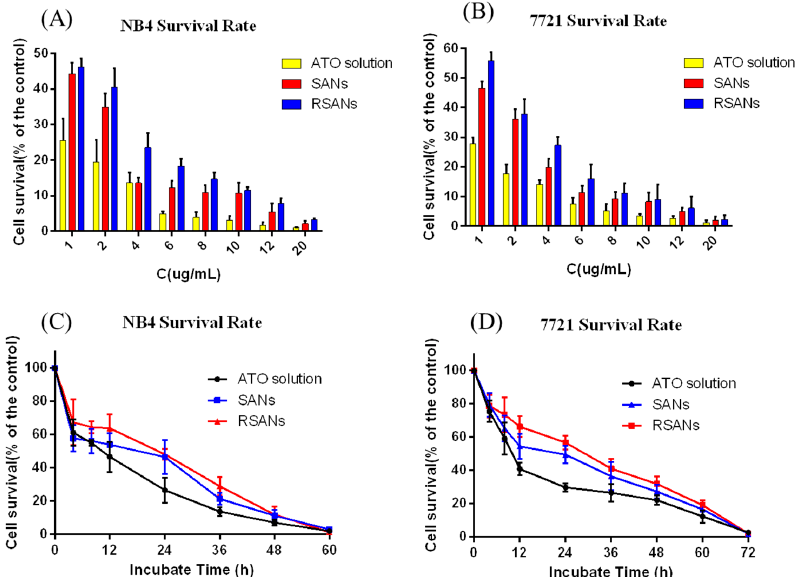
Figure 9. The inhibition effects on NB4 and 7721 cells after administration with different formulations. Cell survival of NB4 ( A ) and 7721 ( B ) cells after administration with different Cell survival of NB4 ( A ) and 7721 ( B ) cells after administration with di ff erent concentrations of ATO, concentrations of ATO, SANs and RSANs for 24 h. Cell survival of NB4 ( C ) and 7721( D ) cells after SANs and RSANs for 24 h. Cell survival of NB4 ( C ) and 7721 ( D ) cells after administration with administration with multiple groups at the ATO concentration of 1 μ g/mL for 72 h. Data are shown multiple groups at the ATO concentration of 1 µ g / mL for 72 h. Data are shown as ± SD of the mean as ± SD of the mean ( n = 3). ( n =